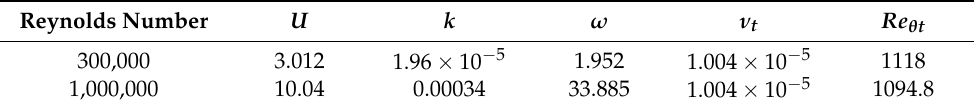
Table 2. Inlet boundary conditions of the NACA 16012